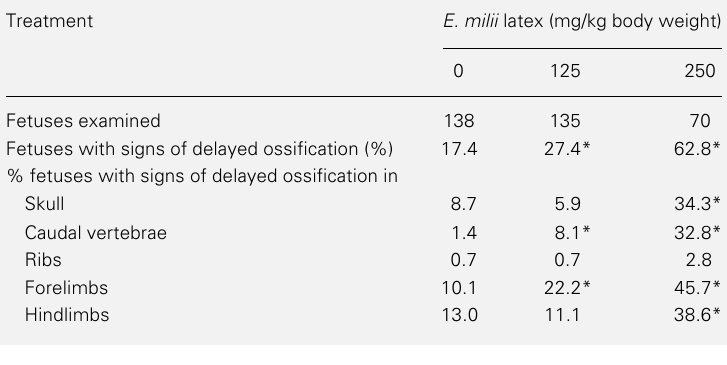
Table 3 - Occurrence of signs of delayed ossification in the offspring of rats treated orally with E. milii latex (0, 125 and 250 mg/kg) on pregnancy days 6-15. Signs of delayed ossification: not ossified (whole bone not stained); poorly ossified (whole bone is poorly ossified), and irregular spongy bones. Data were analyzed by the chi-square test or by the Fisher exact test. *P<0.05 vs control. Because of the high resorption rate at the highest dose tested (500 mg/kg), only six fetuses of this group were available for skeleton examination, and thus they were not included in the table.